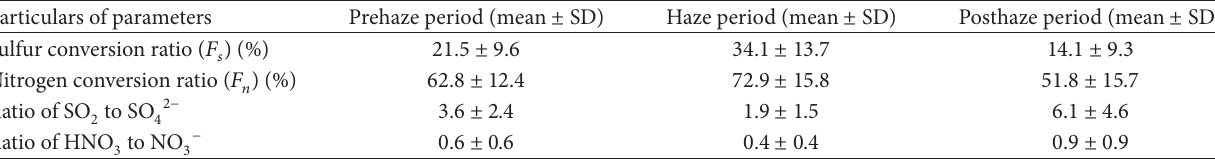
Table 3: Indicators for formation of secondary formation during three